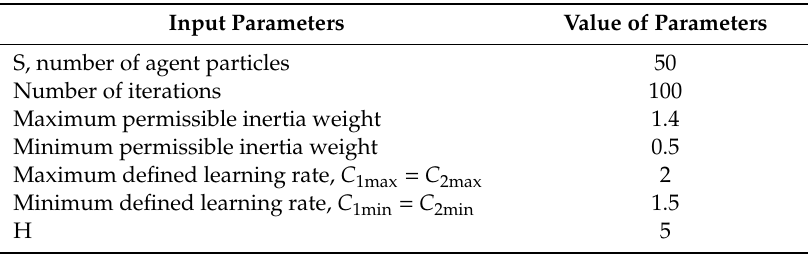
Table 7. Initial parameters of PSO.